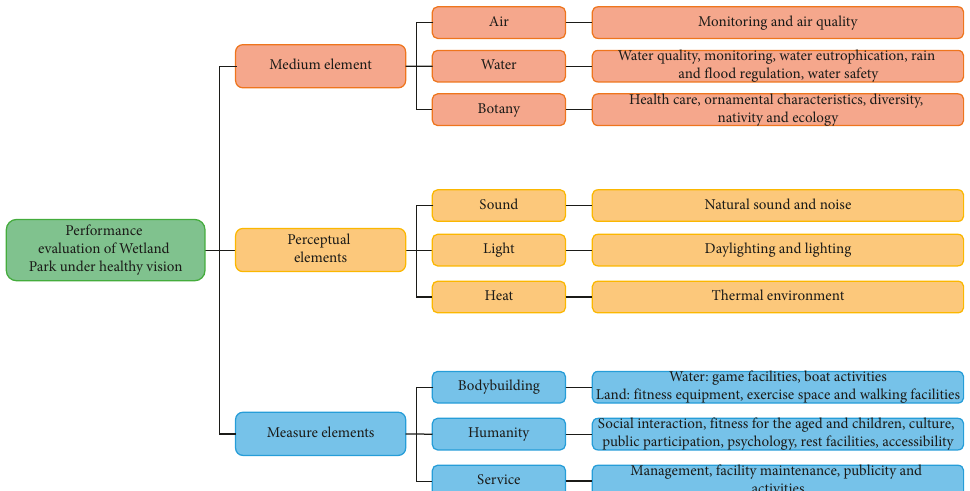
Figure 5: Schematic diagram of influencing factors of wetland park performance evaluation from a health